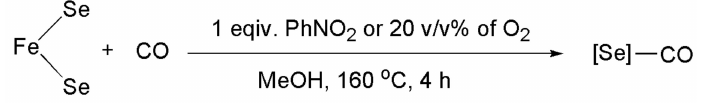
Scheme 3. The reaction of FeSe 2 and CO in the presence of